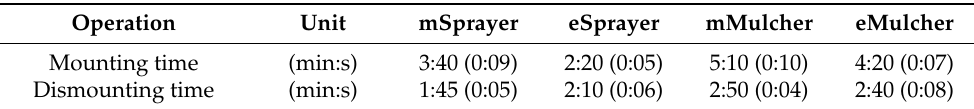
Table 6. Hitching time of the implements. In the brackets, the standard deviation is reported for each